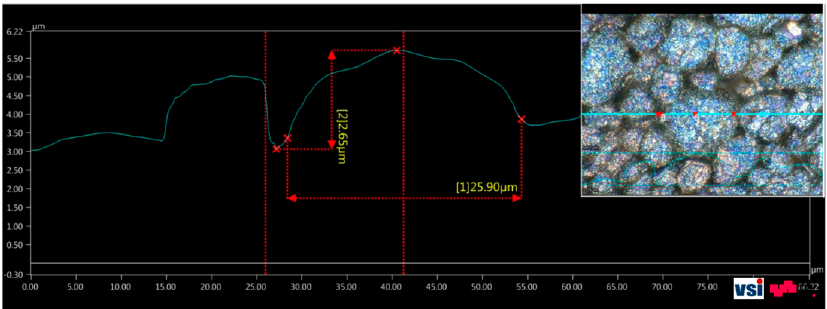
Figure 14. Measurement of particle sizes in the anode surface material with an optical microscope.